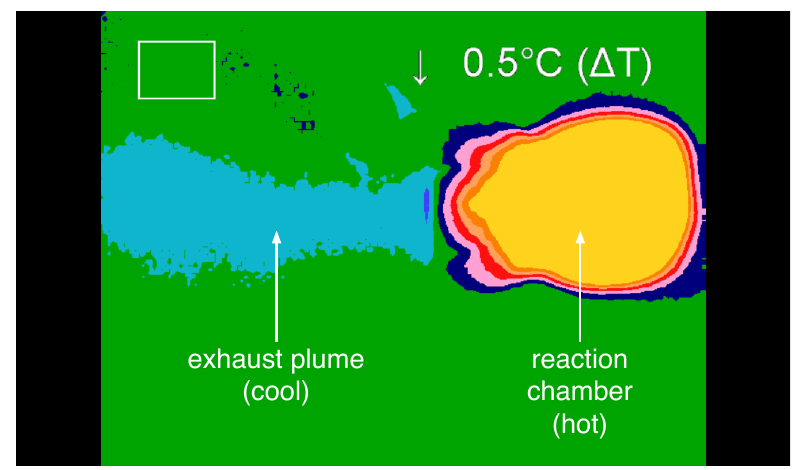
Figure 14. A thermal image of steady-state operation of the thruster using 15% aqueous ferric chloride as the catalyst solution and 87.6% HTP. The large temperature difference between the hot thruster reaction chamber (yellow) and cool exit plume (blue) is suggestive of supersonic operation.